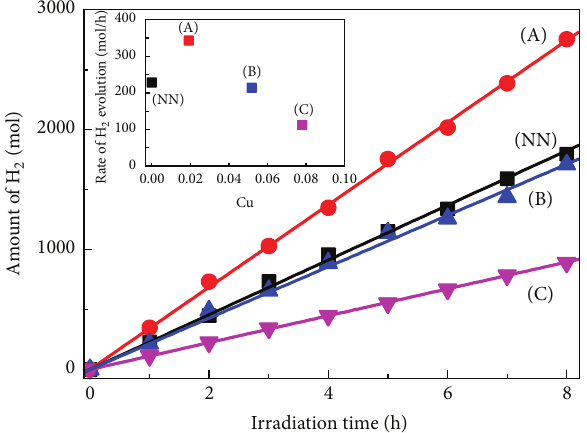
Figure 4: Amount of H 2 evolution from aqueous methanol solution varied with irradiation time over NN, A, B, and C. The inset is the plot of rate of H 2